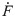
FAK mechano-signaling.A) Rupture force F as a function of the loading rate F˙, where F is defined as the maximal force observed during FK-FAK activation (arrow in the inset). Light grey dots represent individual rupture forces F observed in our membrane-free FPMD simulations. Dark grey dots represent their averages (for each loading rate F˙). The solid line shows the mean rupture force 〈F〉 predicted by the BSK model [45] for ΔG = 28.5 k
B
T, x
b = 0.86 nm, and D = 6.6 × 106 nm2/s. A fit with the HS [44] model yields similar model parameters (not shown). Dashed lines show the variation of the rupture forces predicted by the BSK model (2 standard deviations, see S1 Text for a detailed analysis). Pulling membrane-bound FK-FAK diagonally yielded similarly large rupture forces (green dots). Vertical pulling resulted in significantly lower rupture forces (pink dots), as this direction promotes the less resistant zipper-like dissociation mechanism described in S4B and S4C Fig) Time at which 50% of inactive FAK (B) and GDP-bound Ras protein (C) are consumed, under varying external force. Times obtained for three sets of parameters (1 to 3) corresponding to the three fits presented in S6 Fig.